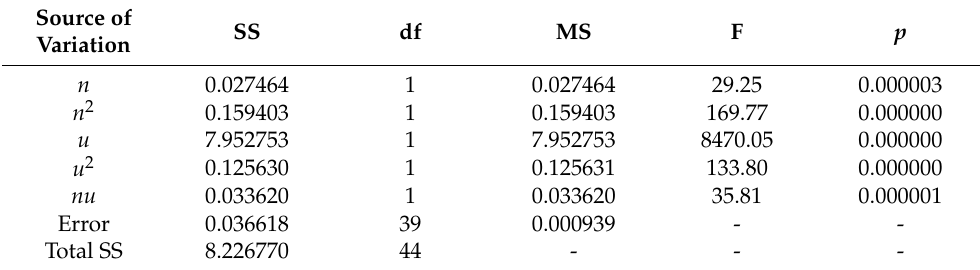
Table 8. Model of melt flow rate ( MFR )—ANOVA table. R 2 = 0.99; R adj2 = 0.99.